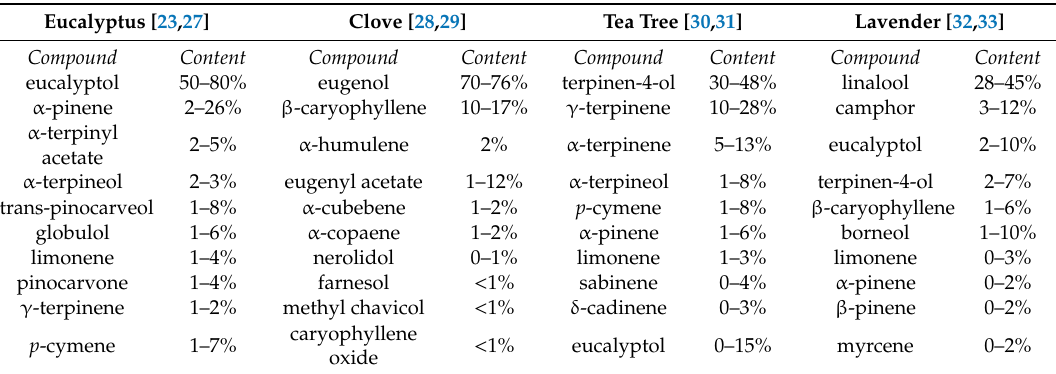
Table 1. Main components of selected essential